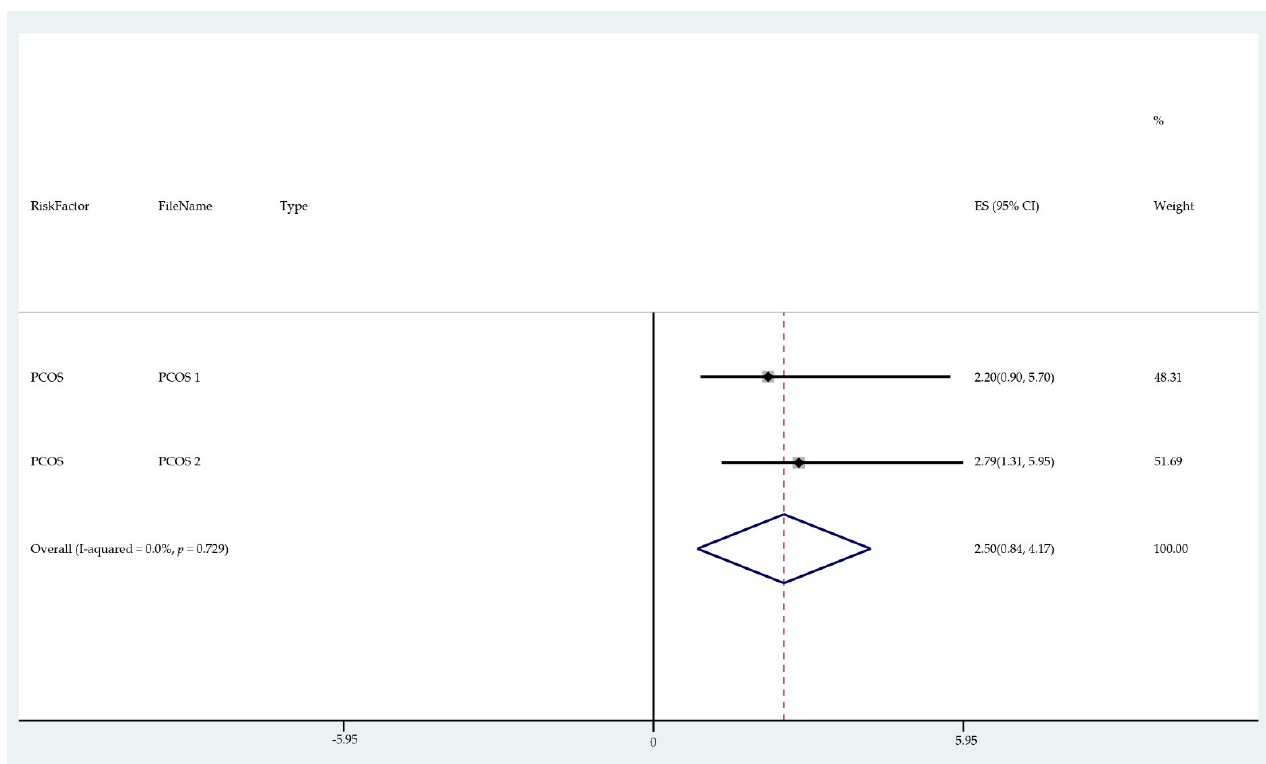
Figure 11. Forest plot to show risk of PCOS.